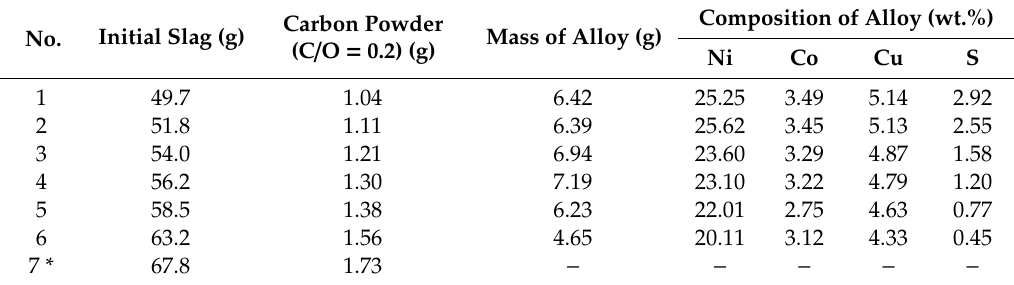
Table 2. Experimental schemes for the reduction of the desulfurized slag with carbon powder. Composition of Alloy Carbon Powder Mass of Alloy (g) No. Initial Slag (g) (C / O = 0.2) (g)